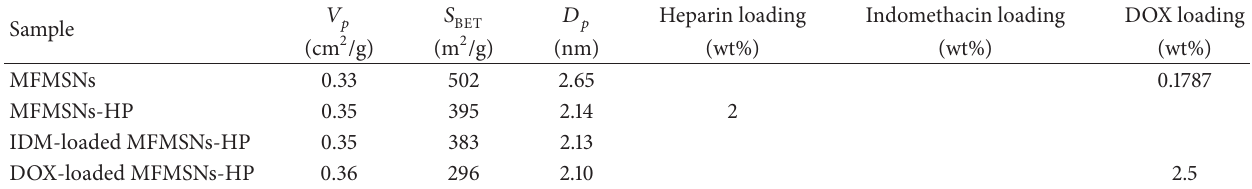
Table 1: Structural parameters of MFMSNs, MFMSNs-HP, IDM-loaded MFMSNs-HP, and DOX-loaded MFMSNs-HP. Sample MFMSNs